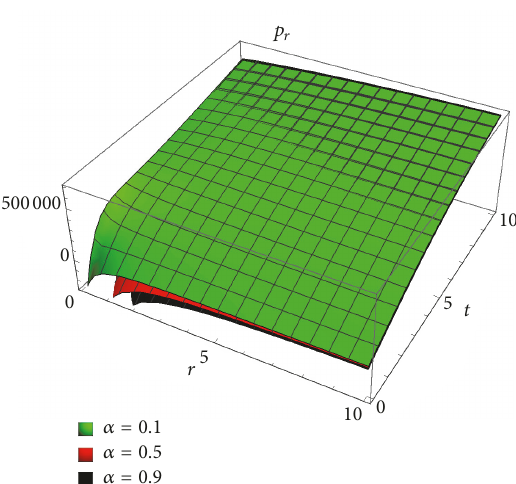
Figure 2: Behavior of radial pressure along 𝑟 and 𝑡 for 𝑘 = 2.5 and the different values of 𝛼 .